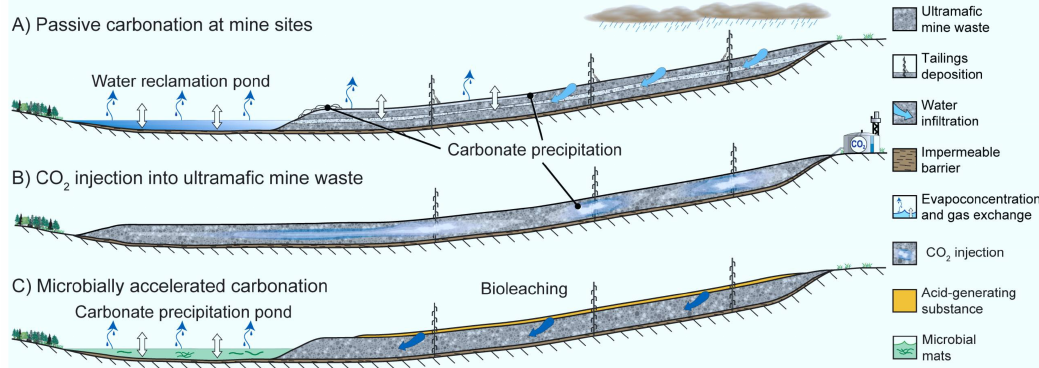
Figure 3. A schematic of three mine tailings facilities depicting: ( A ) passive carbonation under conventional tailings management; ( B ) CO 2 injection; and ( C ) biological approaches incorporating bioleaching and microbial carbonate precipitation. Modified from Power et al.